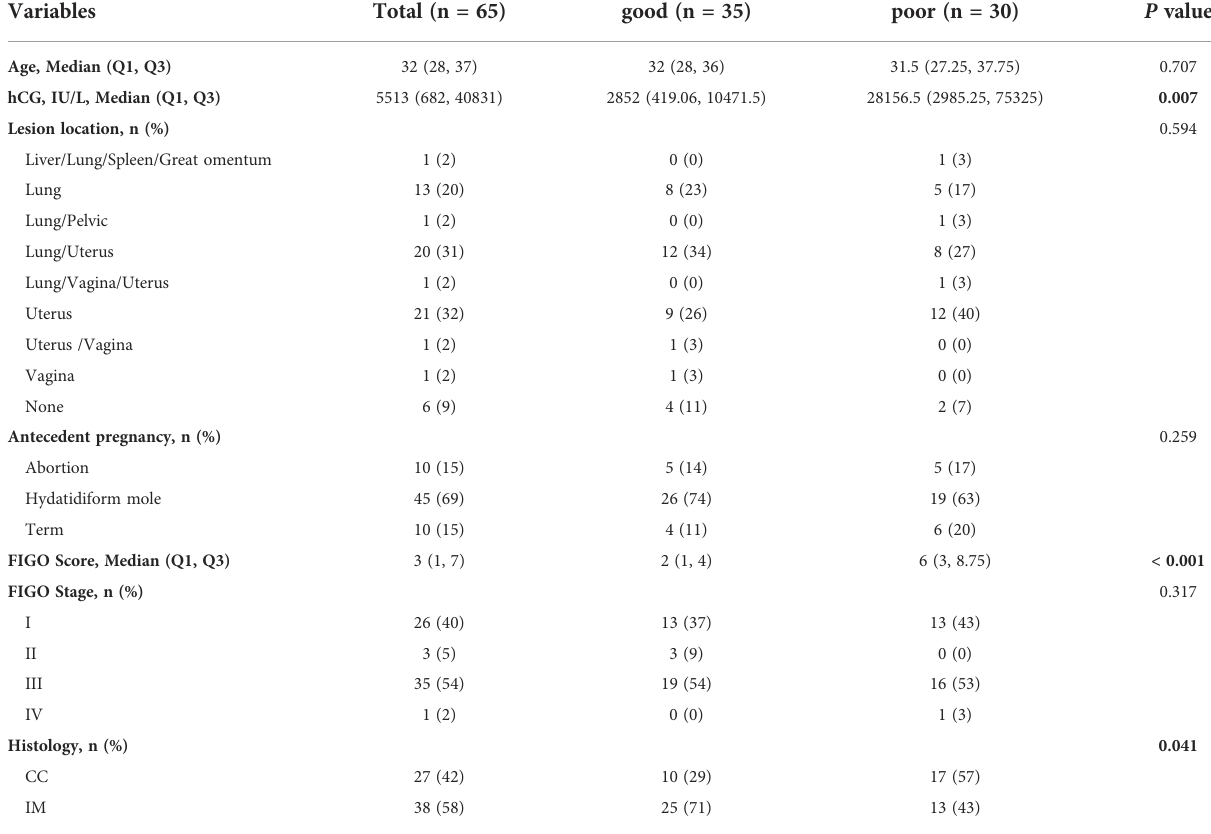
FIGO, International Federation of Gynecology and Obstetrics; CC, choriocarcinoma; IM, invasive mole. Bold shows the heading of the table or the p-value